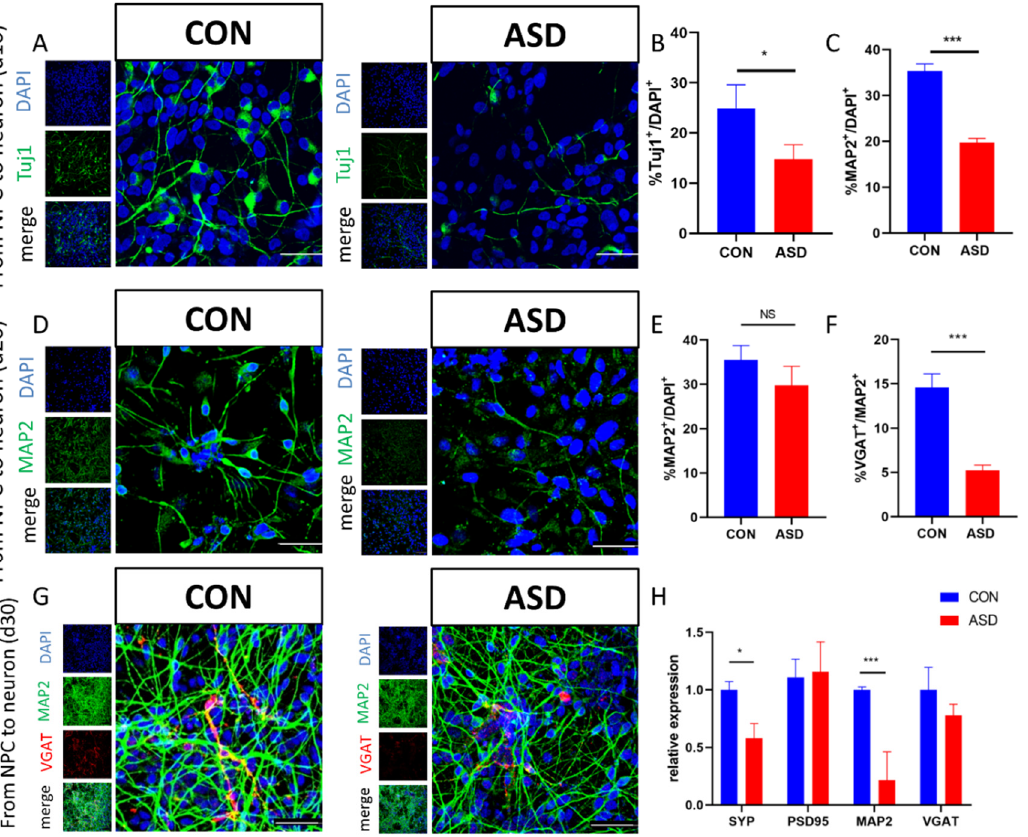
Figure 3. Impaired differentiation of ASD-NPCs. ( A , B ) Representative images of TUJ1 (green)-expressing neurons derived from CON and ASD-NPCs at day 10. DAPI (blue) was used to stain nuclei. The percentage of TUJ1-labeled cells was calculated. ( C , D ) Representative images of MAP2 (green)-expressing neurons derived from CON and ASD-NPCs at day 20. The percentage of MAP2-labeled cells was calculated. ( E – G ) Representative images of MAP2 (green) and VGAT (red)-expressing neurons derived from CON and ASD-NPCs at day 30. The percentage of MAP2- and VGAT-labeled cells was calculated. ( H ) Relative mRNA expression of MAP2, PSD95, SYP, and VGAT in control and ASD-NPCs at day 30 as determined by RT-qPCR. All data represent mean ± SEM; scale bar: 50 µm; *** p < 0.001, * p < 0.05.